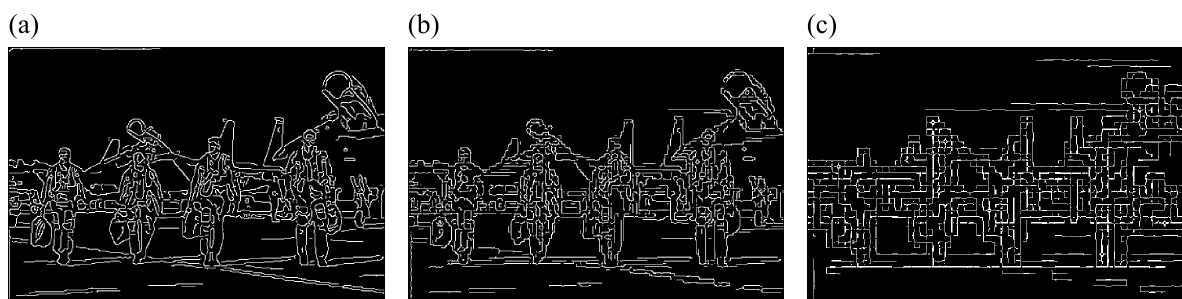
Fig. 10. The example of an image with MD where the Canny edge detection operator was applied to three levels of decomposition for the Haar wavelet transformation. (a) Level 1, (b) Level 2, (c) Level 3.